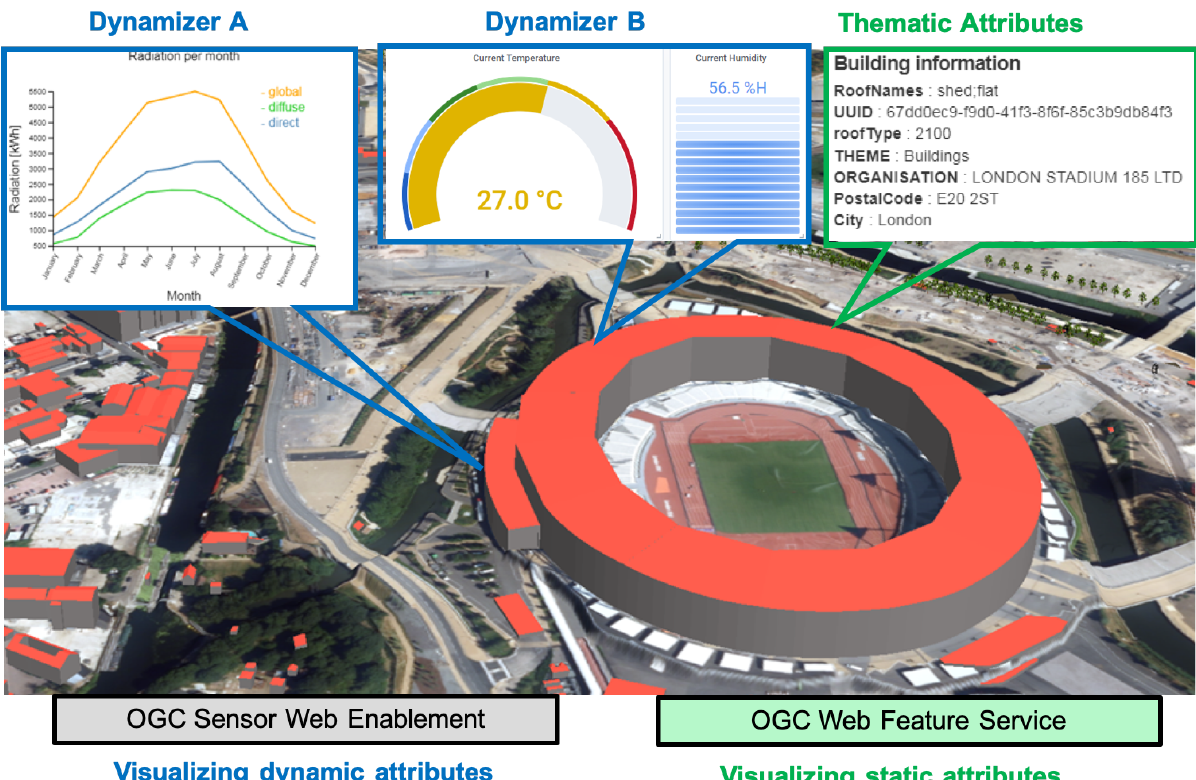
Figure 4. Illustration of an integrated visualization of a building’s static thematic attributes and dynamic properties being retrieved from Dynamizer A (solar potential simulation results stored in-line with the Building object) and Dynamizer B (explicit links to the real-time sensor